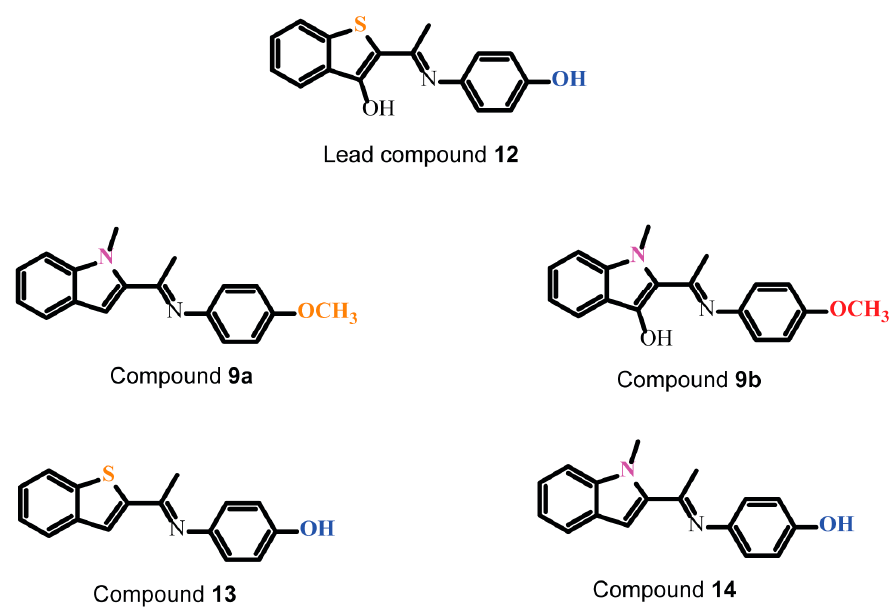
Figure 2. Chemical structure of the G α i 2 Inhibitors. Compounds 13 and 14 are analogs of ketamine 12 lacking the thiophene OH-group and with thiol- to N-methyl amino-group substitution, respectively. lacking the thiophene OH ‐ group and with thiol ‐ to N ‐ methyl amino ‐ group substitution, respectively. Compounds 9a and 9b are derivatives of 14, designed to test the e ff ect of modification to the phenolic Compounds 9a and 9b are derivatives of 14, designed to test the effect of modification to the phenolic group on G α i 2 inhibition group on G α i 2 inhibition activity.